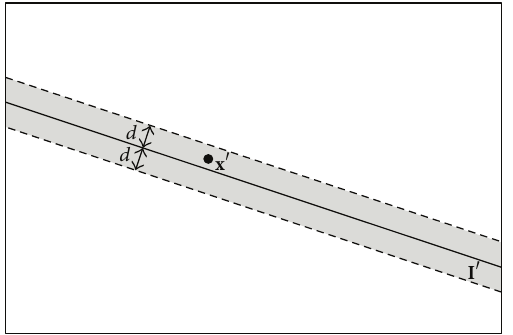
Figure 8: Determining potential match based on epipolar con-